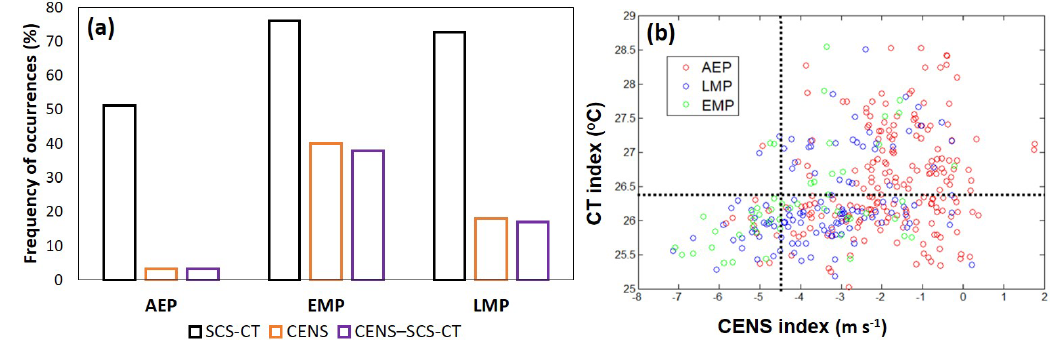
Figure 7. (a) Frequency of occurrence of SCS-CT (black), CENS (orange), and CENS-SCS-CT (purple) corresponding to the three diurnal phases of peak precipitation AEP, EMP, and LMP; (b) scatter plot between SCS-CT and CENS indices for AEP, LMP, and EMP as indicated by red, blue, and green circles, respectively. Threshold values for SCS-CT (26.4 ◦ C) and CENS ( − 45ms − 1 ) indices are indicated by black dotted lines.